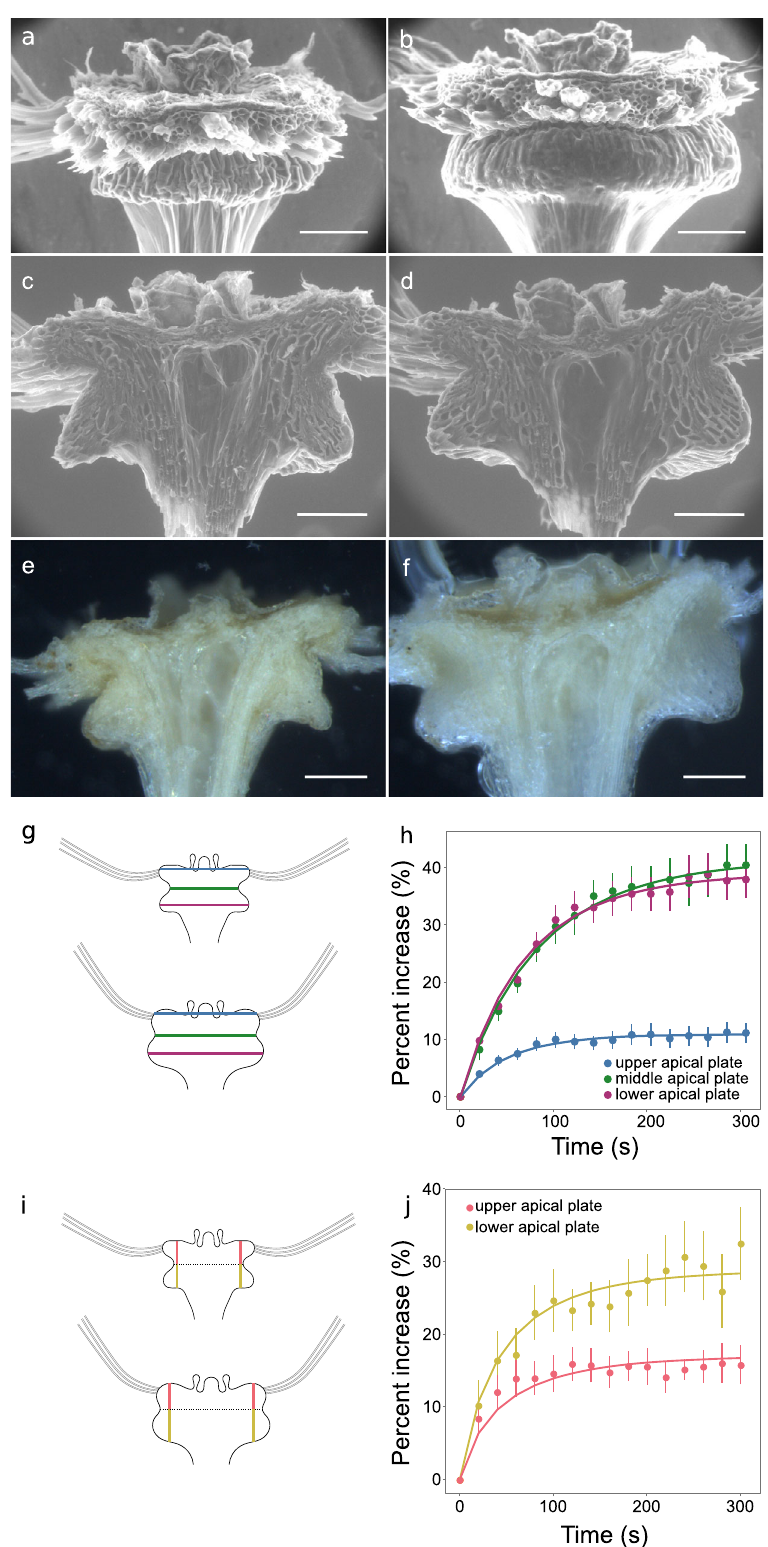
Fig. 2 Apical plate expansion during hydration. a – d Environmental SEM images of apical plate samples before, a , c , or after, b , d , hydration. a , b Intact sample with the majority of hairs removed. Images are representative of n = 3 samples. c , d Longitudinal half-sections. Images are representative of n = 10 samples. e , f Light microscopy images of longitudinal half-sections of an apical plate imaged before e , and after f , hydration. Images are representative of n = 19 samples. g Schematic illustrating the locations of radial measurement, h Quanti fi cation of radial expansion in half-sections imaged with light microscopy, n = 10, error bars are standard error of the mean. i Schematic illustrating the locations of longitudinal measurement, j Quanti fi cation of longitudinal expansion in half-sections imaged with light microscopy, n = 10, error bars are standard error of the mean. Scale bars are 100 μ